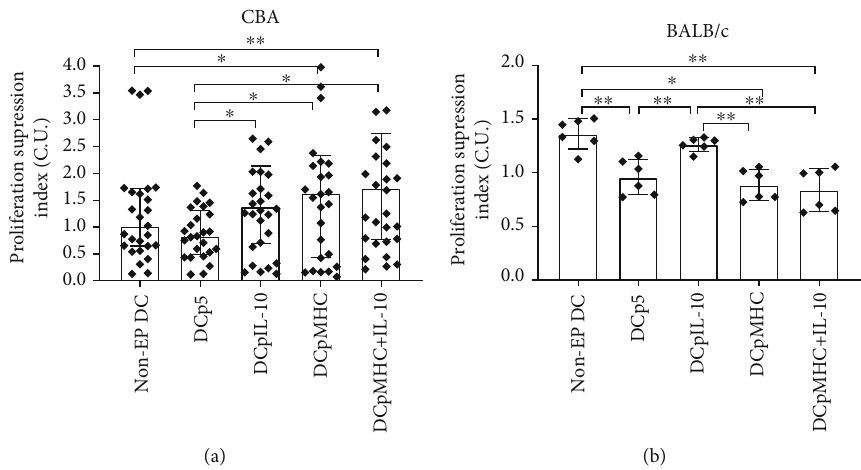
Figure 4: Suppression of proliferation of C57BL/6 mouse splenocytes cocultured with transfected DCs through adding (a) CBA mouse splenocytes ( N = 22 per group) or (b) BALB/c mouse splenocytes ( N = 6 per group). Brackets indicate signi fi cant di ff erences. (a) The data are presented as median and interquartile range (the Kruskal-Wallis test with Dunn ’ s corrected multiple comparisons, P ≤ 0 : 05 ). (b) The data are presented as mean and SD (one-way ANOVA with Tukey ’ s corrected multiple comparisons, ∗ P < 0 : 05 , ∗∗ P < 0 : 01 ). Non-EP DCs: C57Bl/6 splenocytes cocultured with nonelectroporated DCs stimulated with CBA or BALB/c splenocytes; DCp5: C57Bl/6 splenocytes cocultured with DCs electroporated with p5 stimulated with CBA or BALB/c splenocytes; DCpIL-10: C57Bl/6 splenocytes cocultured with DCs electroporated with pIL-10 stimulated with CBA or BALB/c splenocytes; DCpMHC: C57Bl/6 splenocytes cocultured with DCs electroporated with pMHC stimulated with CBA or BALB/c splenocytes; DCpMHC + IL-10: C57Bl/6 splenocytes cocultured with DCs electroporated with pMHC and pIL-10 stimulated with CBA (a) or BALB/c (b)